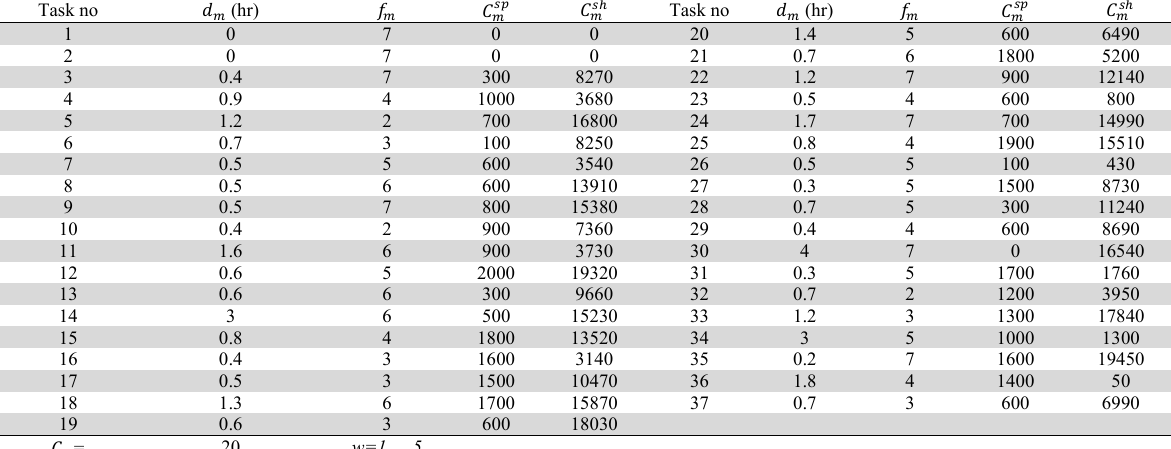
Data of 37 tasks. All costs are in AED.